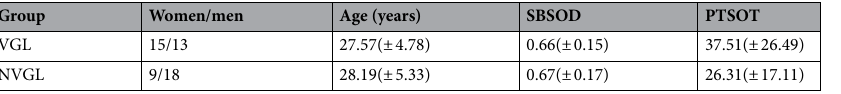
Table 1. Participant demographics and average orienting ability test scores at the initial testing. Standard deviations are shown in parentheses. SBSOD Santa Barbara Sense of Direction scale, PTSOT Perspective Taking/Spatial Orientation